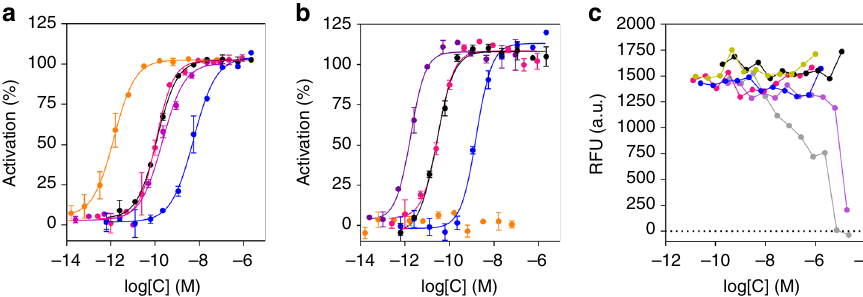
Fig. 5 Agonist potency and cytotoxicity pro fi les of Oxm species. a , b In vitro potencies determined in cAMP accumulation assays in CHO cell lines expressing human GLP-1 a and GCG b receptors of free Oxm (black), released Oxm (magenta), fi brillar Oxm (blue), glucagon (violet), GLP-1 (orange). Data show representative curves of > 5 independent experiments. Curve data are the arithmetic mean ± s.d. of duplicate data points. c 48 h cytotoxicity prolife in CHO-GLP-1R cells of vehicle (yellow), free Oxm (black), released Oxm (magenta), fi brillar Oxm (blue), Ro-318220 (violet), Staurosporine (gray). RFU = Relative fl uorescence units. Data show representative curves of three independent experiments